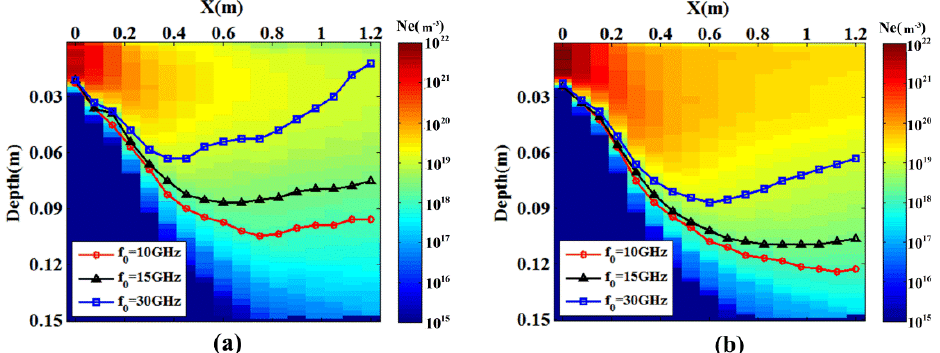
Figure 11. The reflective surface of plasma sheath for scenes 4 and 5. ( a ) Velocity is Mach 20. ( b ) Velocity is Mach 25.